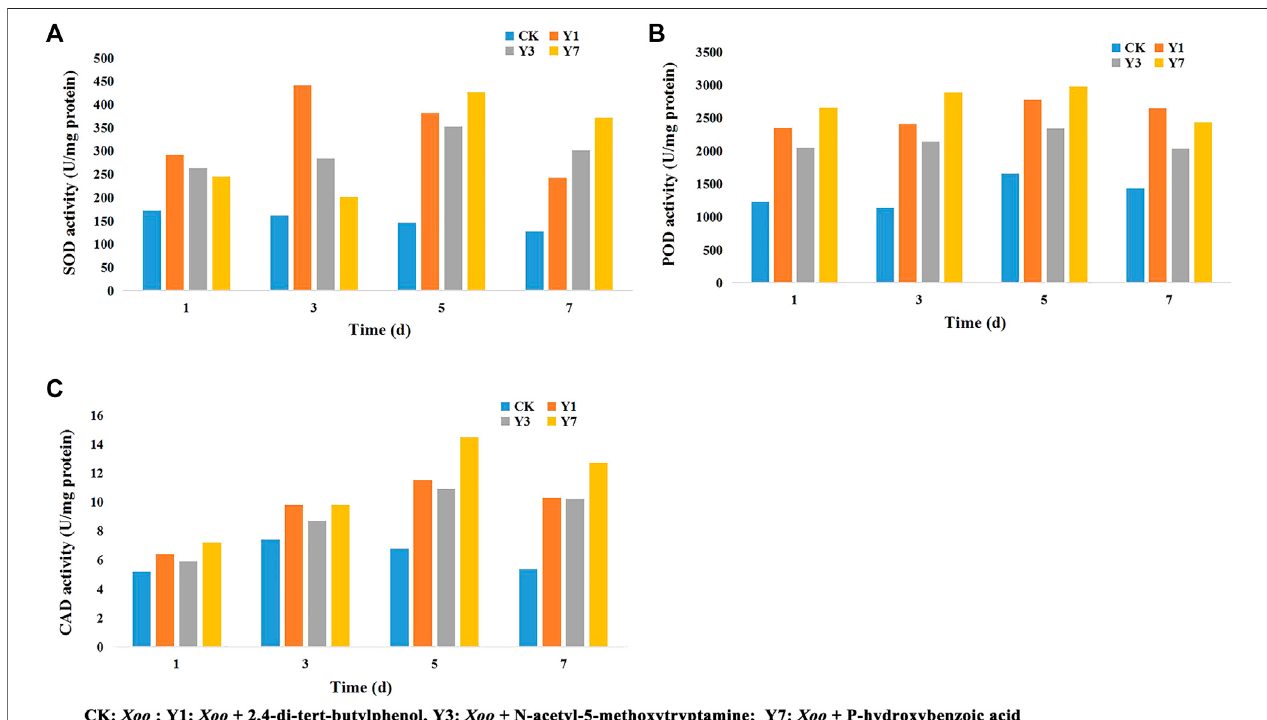
FIGURE 6 | Effects of 2,4-di-tert-butylphenol, N-acetyl-5-methoxytryptamine, and P-hydroxybenzoic acid on SOD (A) , POD (B) , and CAD (C) activities in rice leaves.